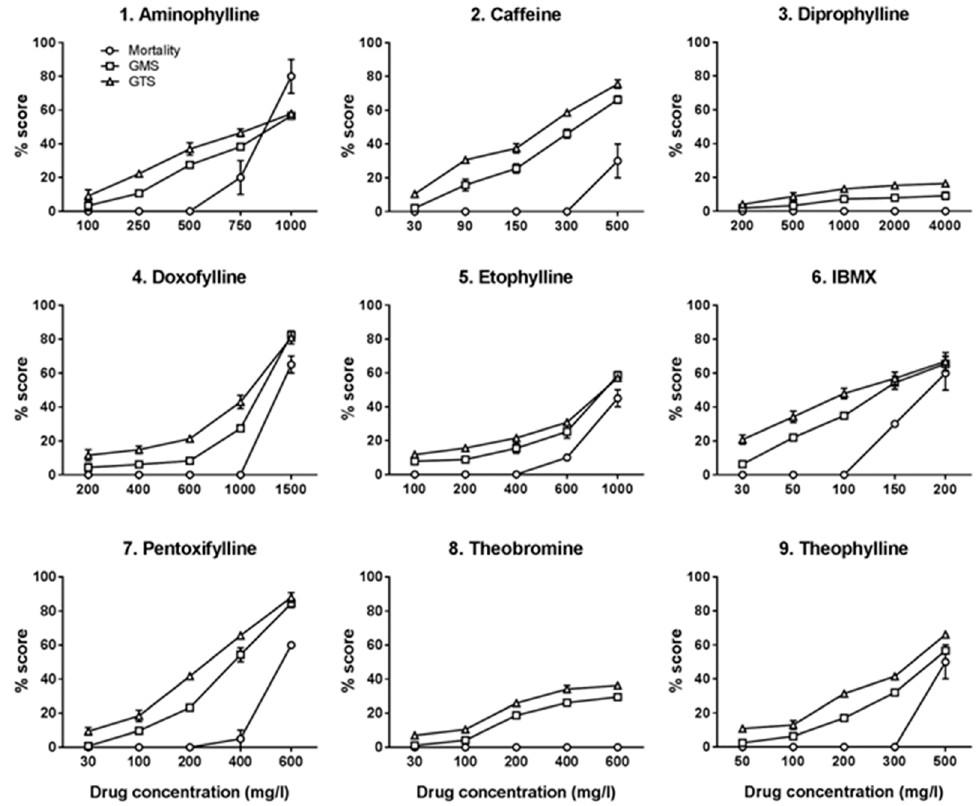
Figure 4. Effect of nine methylxanthine compounds on zebrafish embryos development. X -axis shows the five increasing concentrations of each methylxanthine drug used in the FET test. Data are the mean ± S.D. of three independent experiments. (GMS) General Morphological defects Score; (GTS) General Teratogenicity Score. White circles: mortality rate; white squares: GMS; white triangles: GTS.